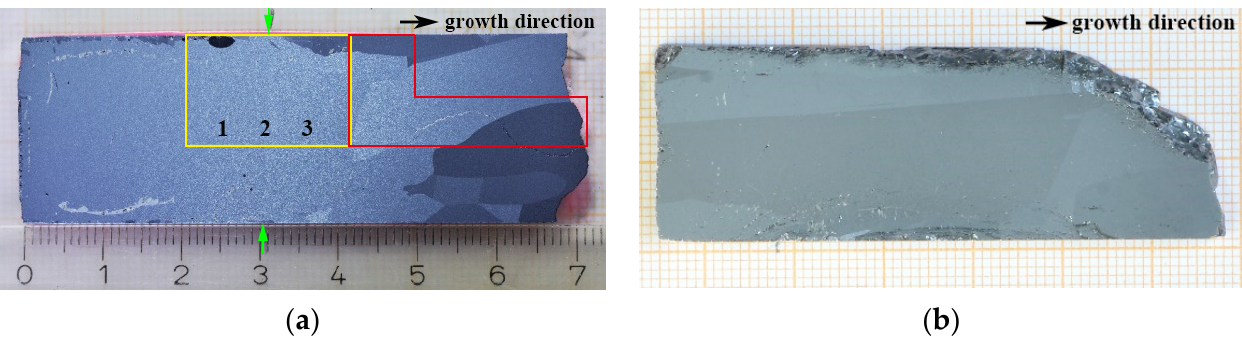
Figure 1. Optical photograph of the slabs cut along the ingot axis: ( a ) F1-02; ( b ) F1-03 [14]. We performed XRD measurements at Position 1, 2, 3 and XWBT in the areas in yellow and red frames.